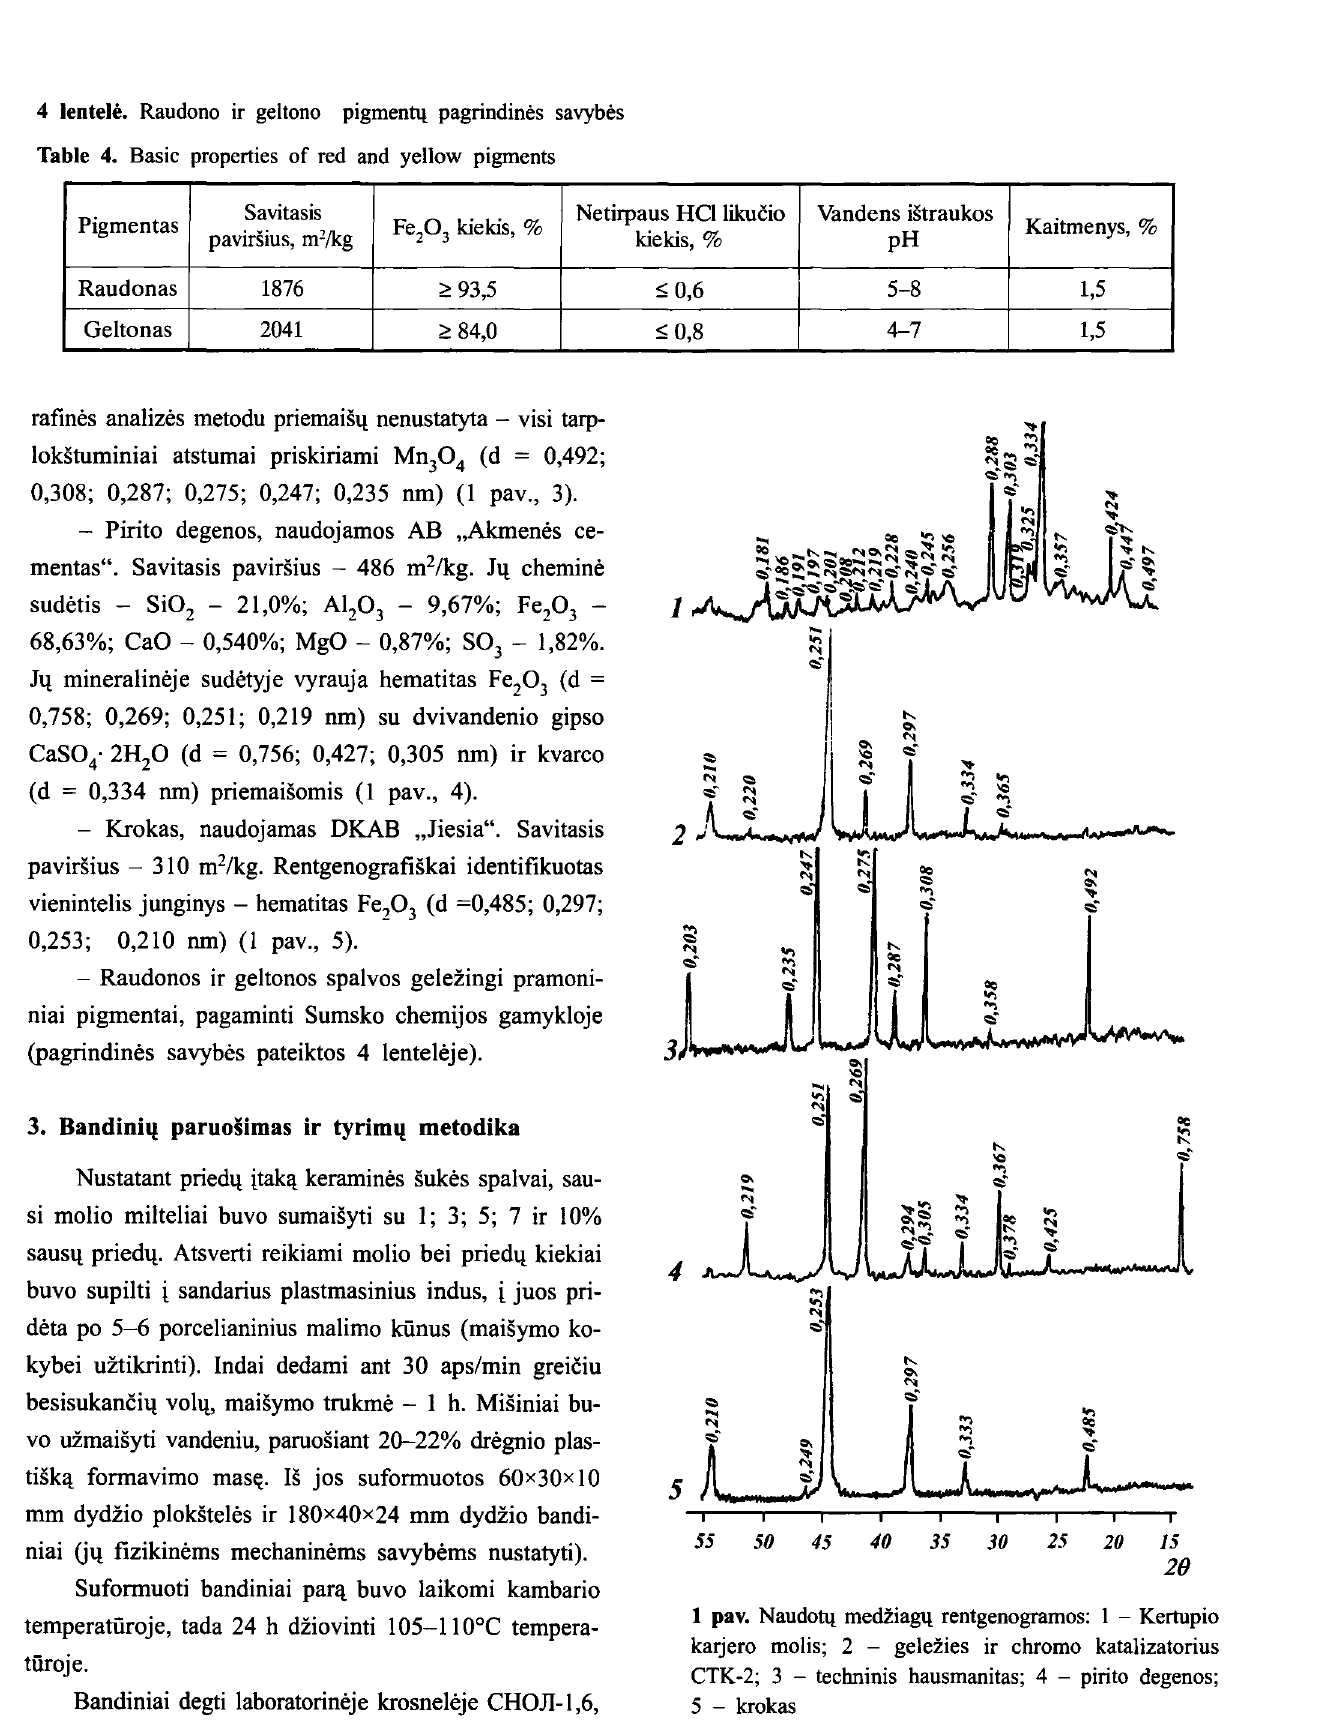
Fig 1. X-ray patterns of used materials: 1 - clay from Kertupis bed; 2 - ferrum-chromium catalyst CTK-2; 3 - technical hausmannite; 4 - burnt pyrite; 5 -